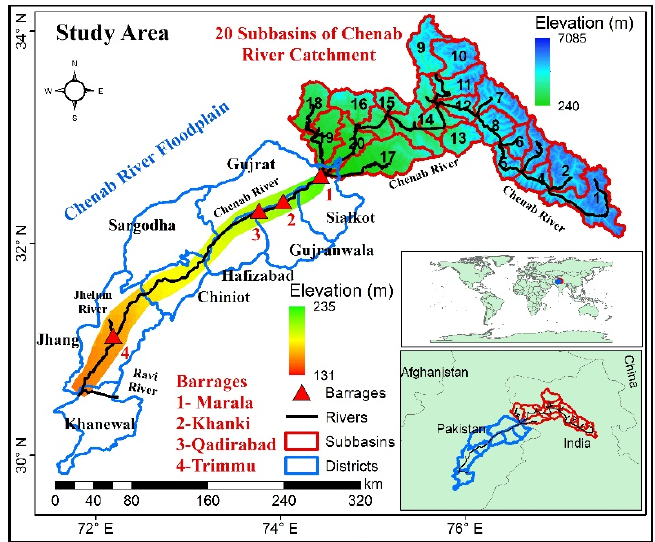
Figure 1. Topographic map of the Chenab River catchment and floodplain. The catchment includes 20 subbasins (black labels from 1 to 20) and the floodplain from the Marala barrage to the Chenab– Ravi Rivers’ confluence. The black lines are the rivers (Chenab, Jhelum, and Ravi), and the red labels from 1 to 4 represent the barrages (Marala, Khanki, Qadirabad, and